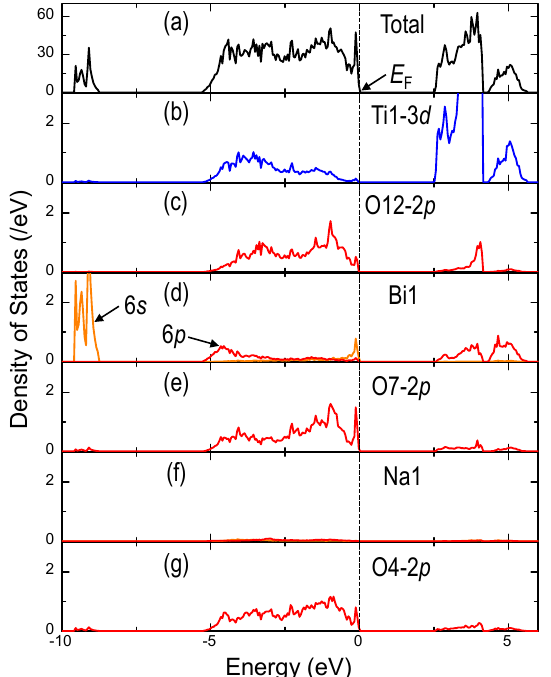
constituent atoms of BNT ( E = 0 kV/cm) obtained by the DFT calculations in in-situ